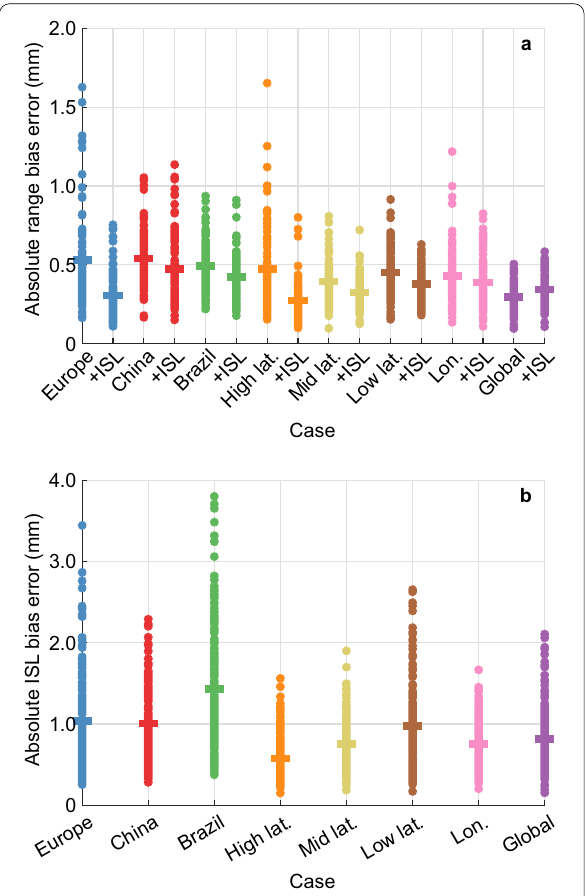
Fig. 4 Absolute bias errors for each case. Top: absolute ground range bias errors; bottom: absolute ISL bias errors (per pair). For each case, bias errors of individual satellites (for ground range biases) and each pair of satellites (for ISL biases) are marked as stars and the mean of all biases is marked as a bar. “ ISL” means that ISL observations + are included in the estimation together with observations from the station network of the same